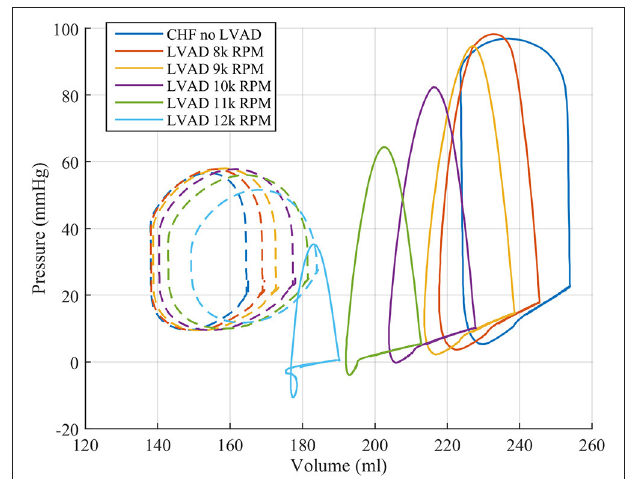
FIGURE 4 | Pressure volume loops for the LV (solid lines) and RV (dashed lines) from the FE model study.